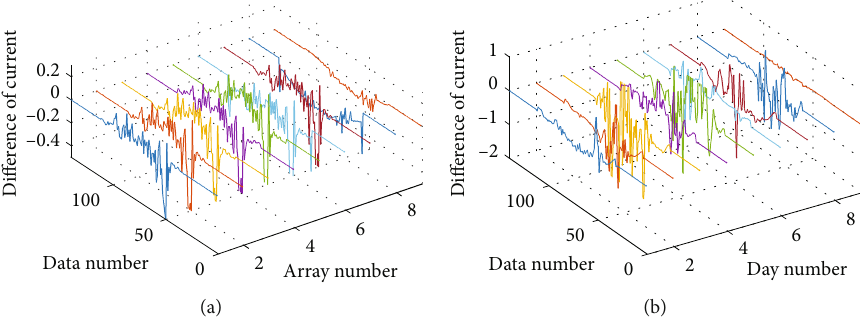
Figure 2: Distribution characteristics of the di ff erence between the array current and the reference current. (a) Di ff erent arrays. (b) Di ff erent days.